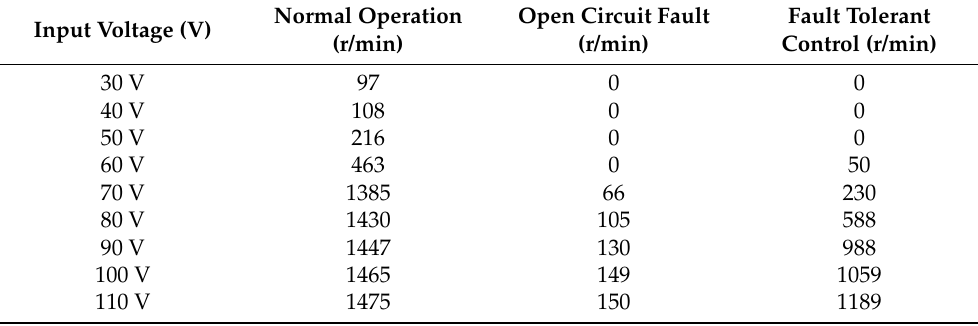
Table 4. Motor speed changes after open-circuit fault of phase AB and fault-tolerant control.